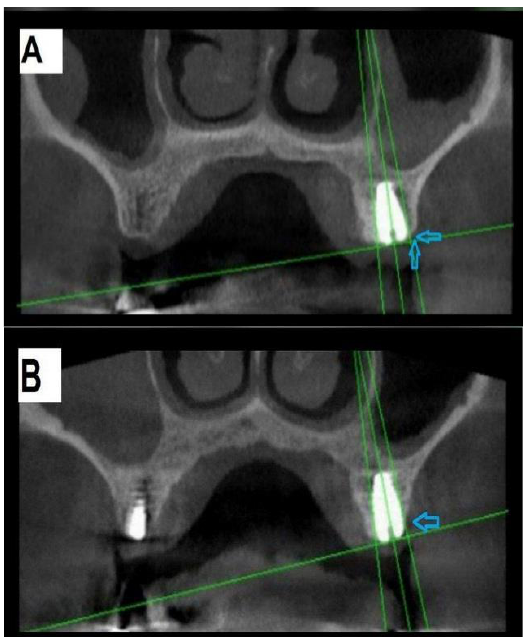
Figure (9): CBCT (oblique view) for the same posterior DI placed with flapped procedure. (A) Immediate post-operative CBCT illustrating the buccal side bone level of DI (arrows) in relation to the horizontal line. (B) 24 weeks post-operative CBCT illustrating the difference in bone level (arrow) that presented as shadow.